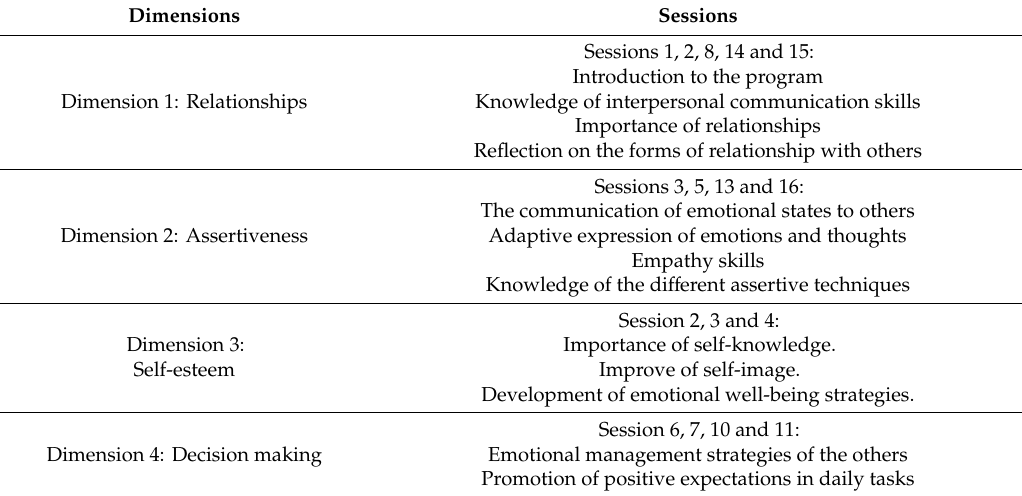
Table 2. Sessions